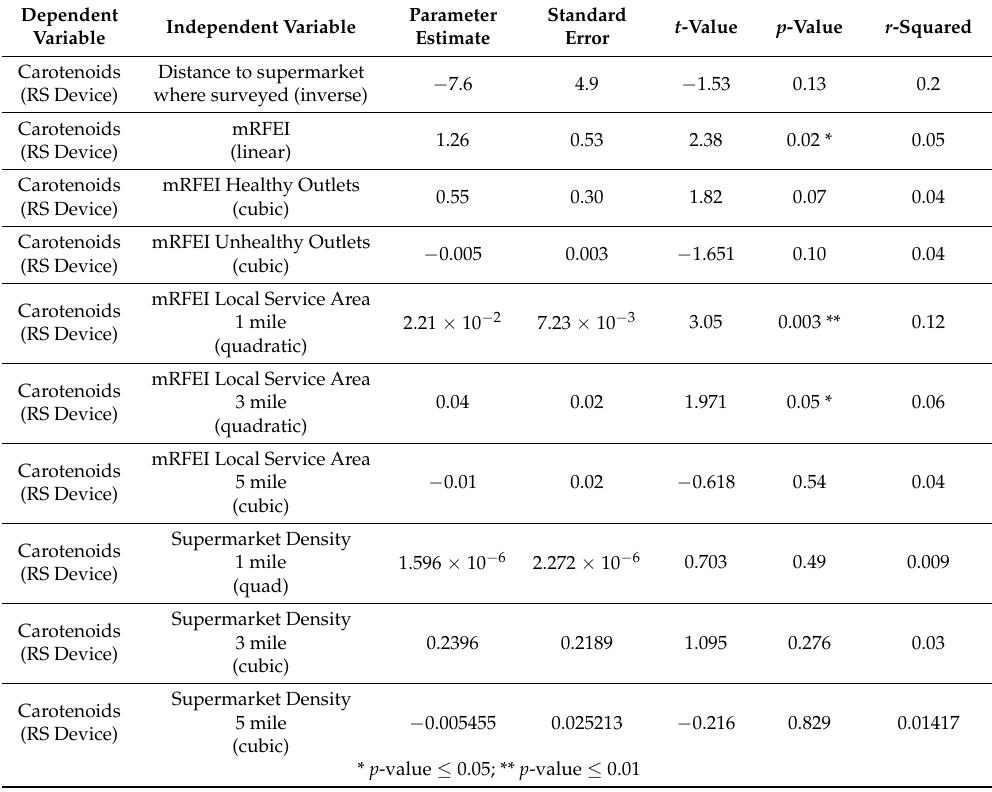
Table 3. Unadjusted regression analyses, with skin carotenoids as the dependent variable, and distance measures as independent variables.